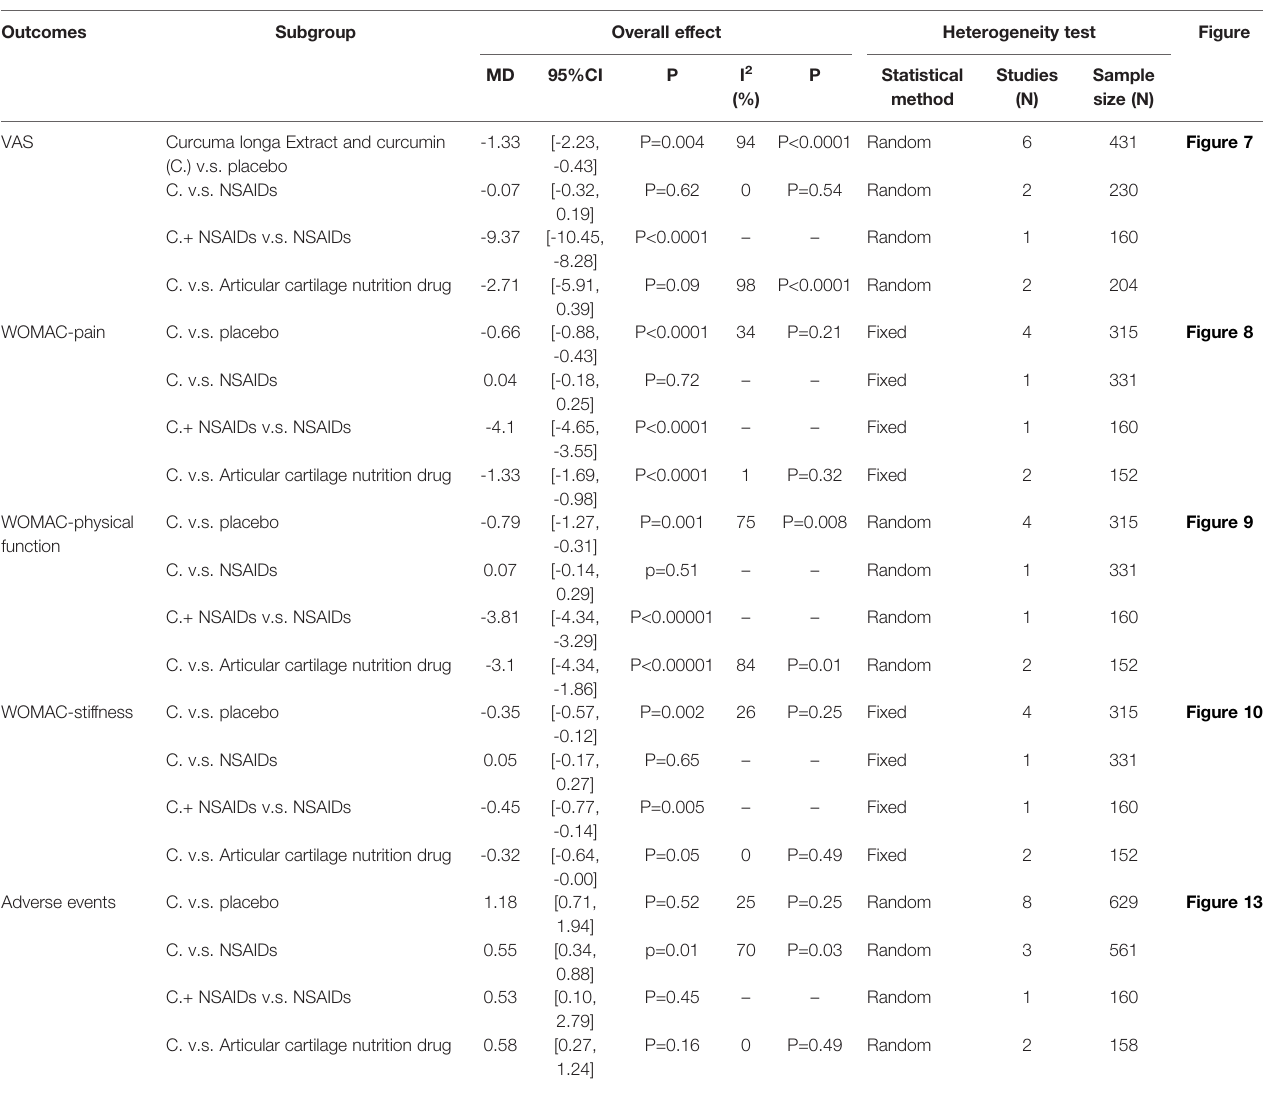
TABLE 2 | The subgroup analysis of OA ef fi cacy indicators and adverse